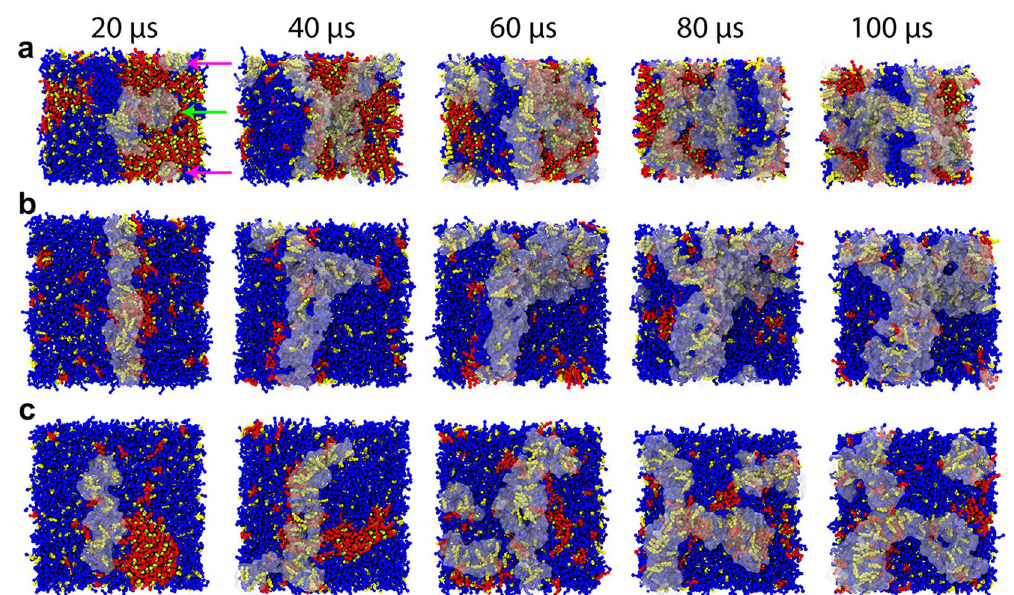
Figure 2. CHOL clustering and disorganization in the lo domain caused by binding of kB1. The binding of kB1 molecules with the ( a ) VI, ( b ) IN, and ( c ) HO membranes are shown from the top view of each system. Only kB1 molecules that directly interact with the membranes are shown, i.e., those with transparent surface models. DPPC, DLiPC and CHOL are shown as CPK models with red, blue, and yellow colors, respectively. The small and large oligomers that initially bind to the lo domain of the VI membrane are indicated with pink and green arrows, respectively. Please note that there is only one small oligomer, which is split by a periodic